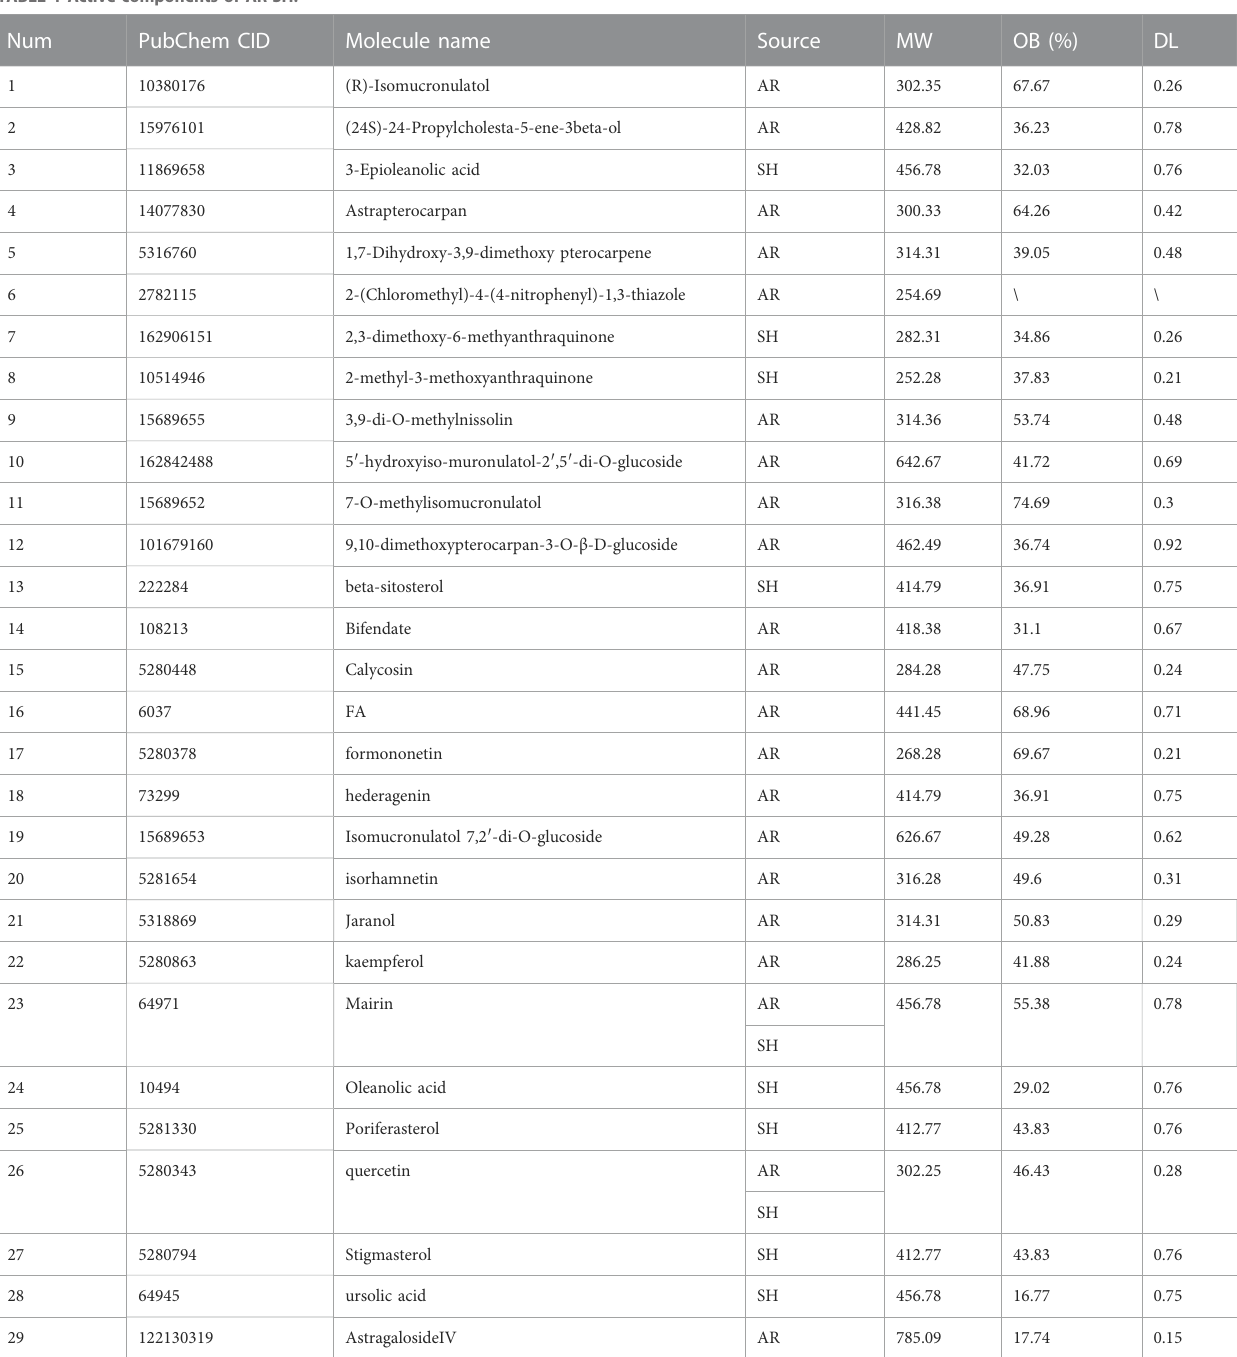
TABLE 1 Active components of AR-SH.